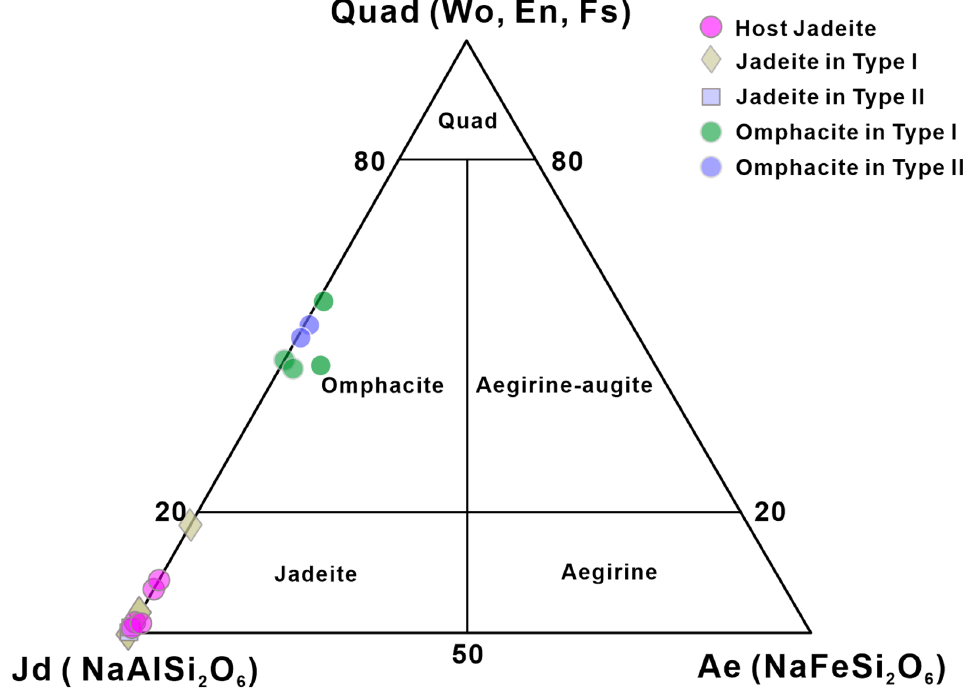
Figure 11. Kazakhstan jadeitite Quad–Jd–Ae triple diagram (modi fi ed from [44]).